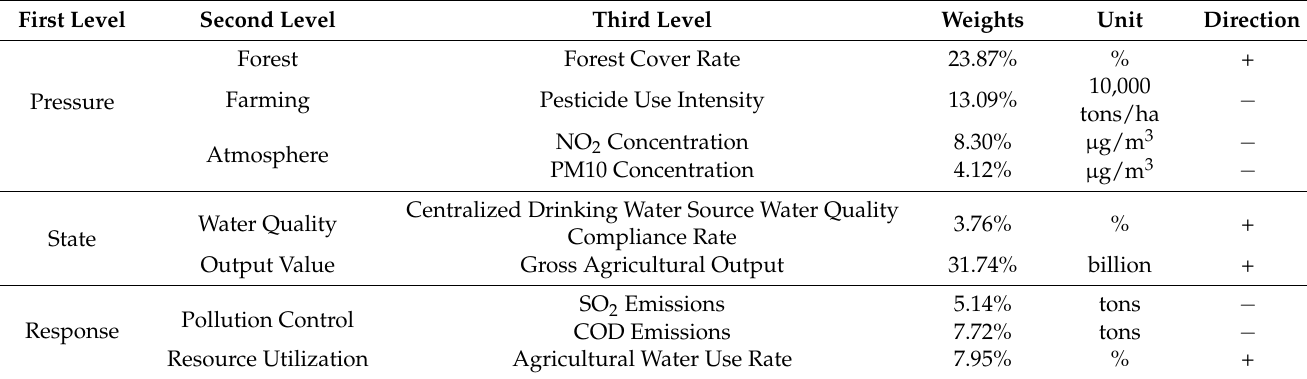
Table 1. Index system